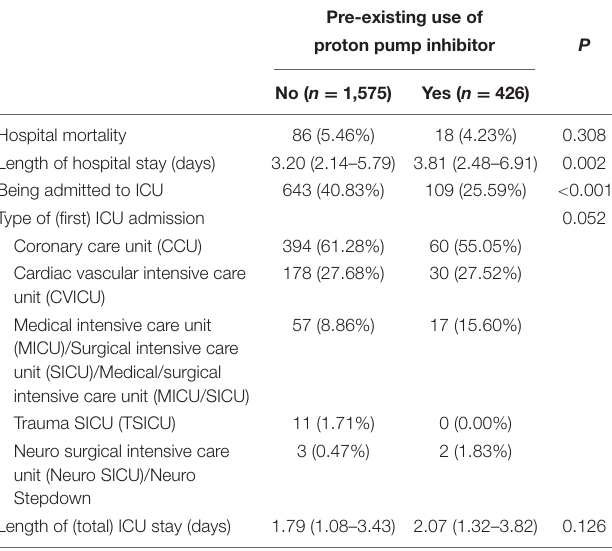
TABLE 2 | Prognosis of the study population according to pre-existing use of proton pump inhibitor.